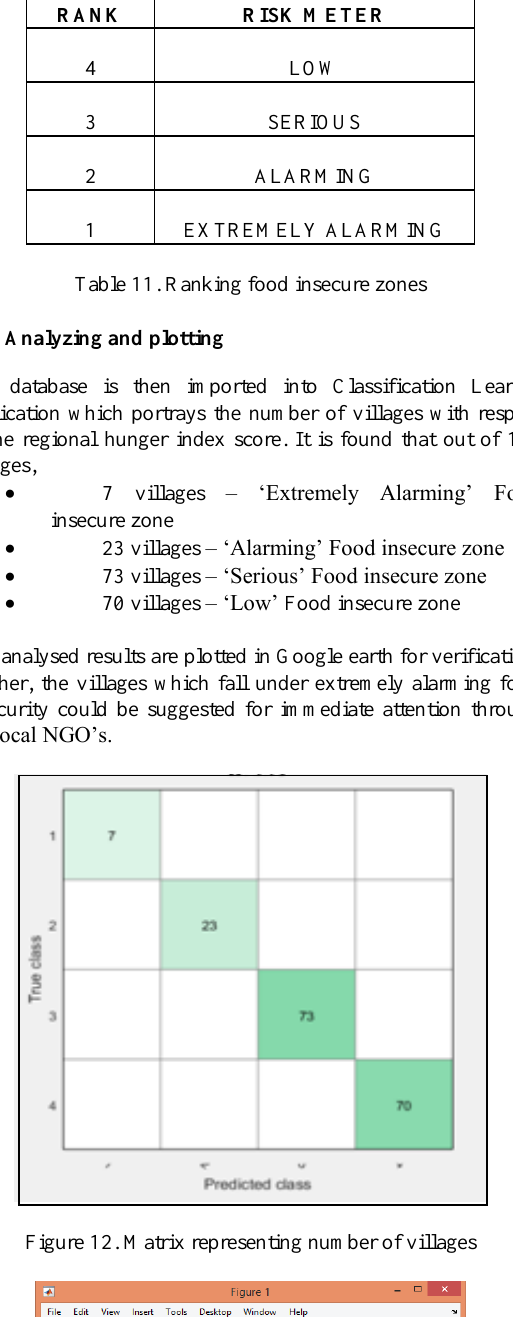
Figure 15. Spatial distribution of Regional hunger